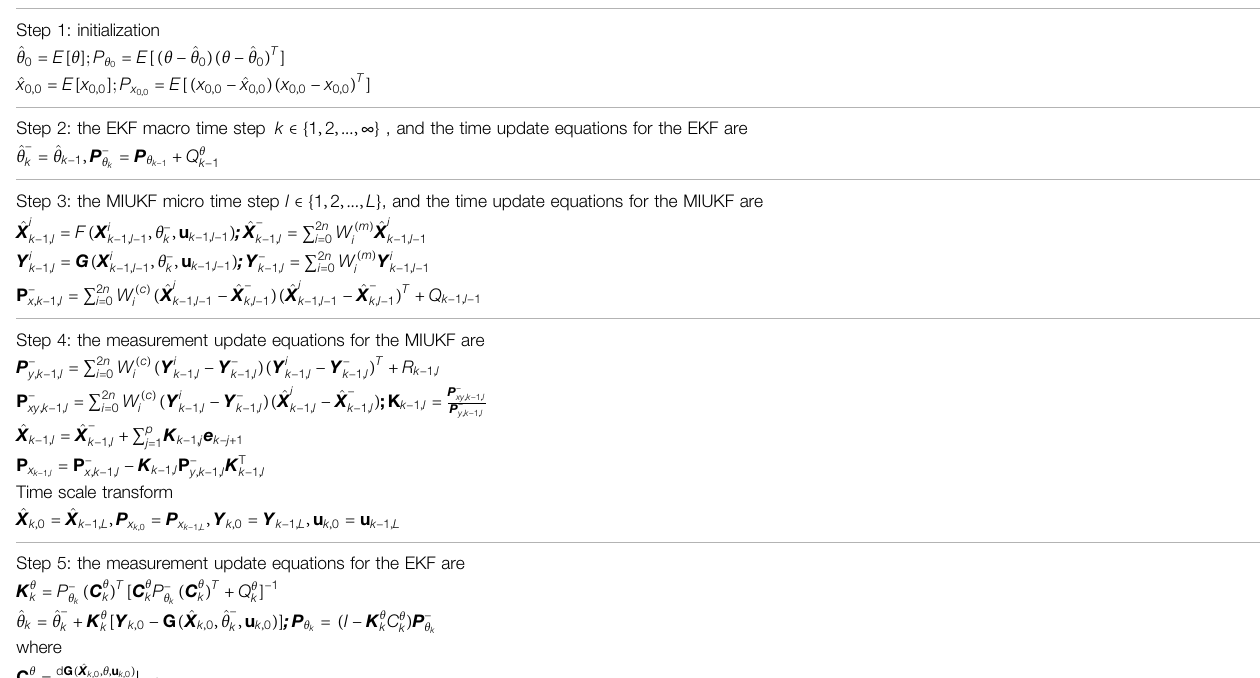
TABLE 1 | Algorithm of the multi scale